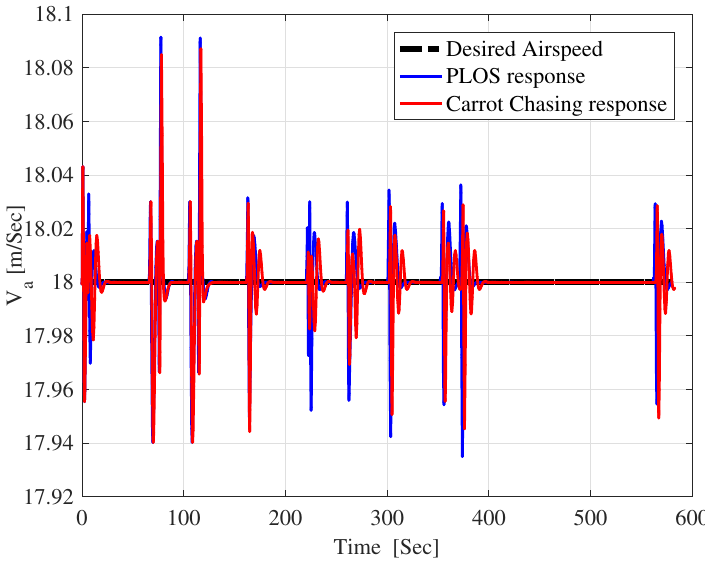
Figure 26. Velocity response under sharply straight line path